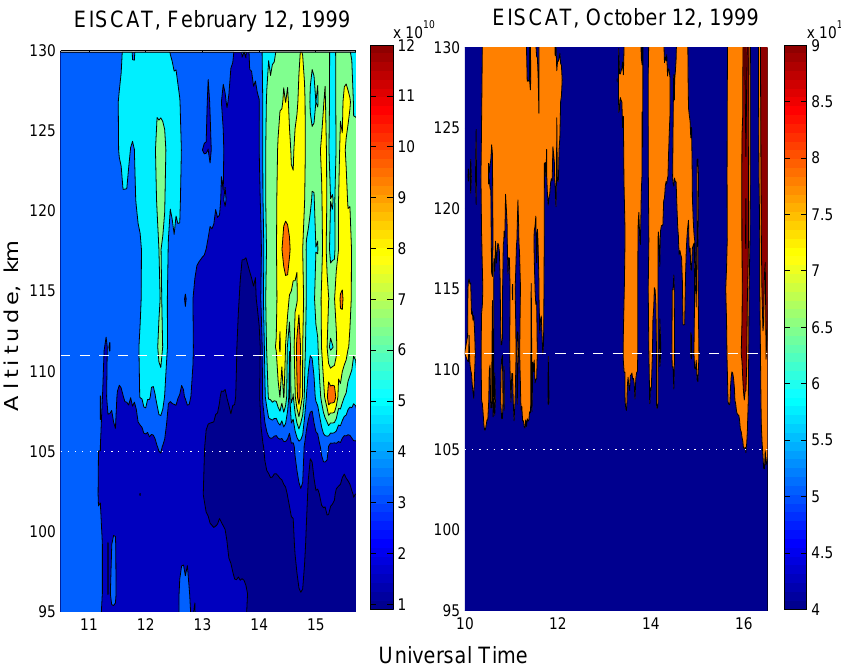
Fig. 2. The EISCAT electron density profiles for two events of this study. Dashed line shows the altitude of 111km used in our calculations, dotted lines show the altitude 105km used in a model estimate by Nielsen and Schlegel (1985), Nielsen et al. (2002).